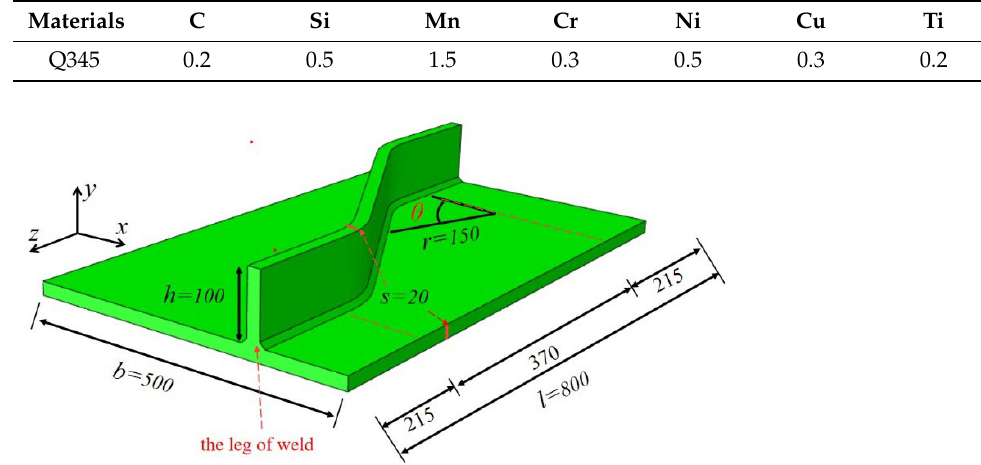
Figure 2. Finite element model of corrugated steel web–chord plate weldment (unit: mm).